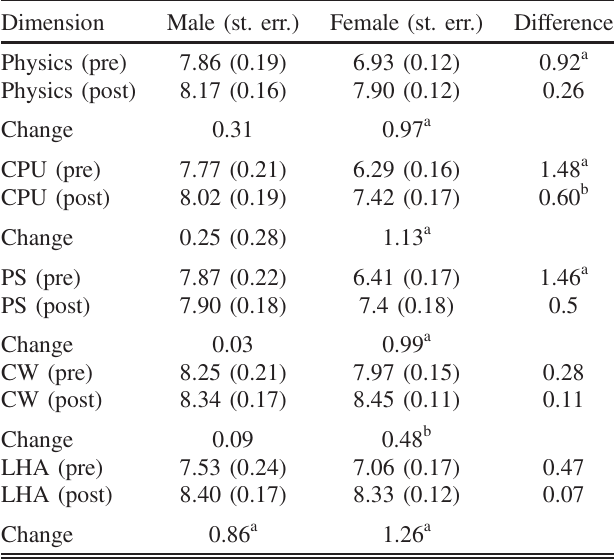
TABLE IV. Average self-efficacy at the beginning (pre) and end (post) of the semester overall and in each of the four dimensions for male and female students showing statistical significance of the changes and differences in each item (st. err. ¼ standard error). Data averaged for 2016 and